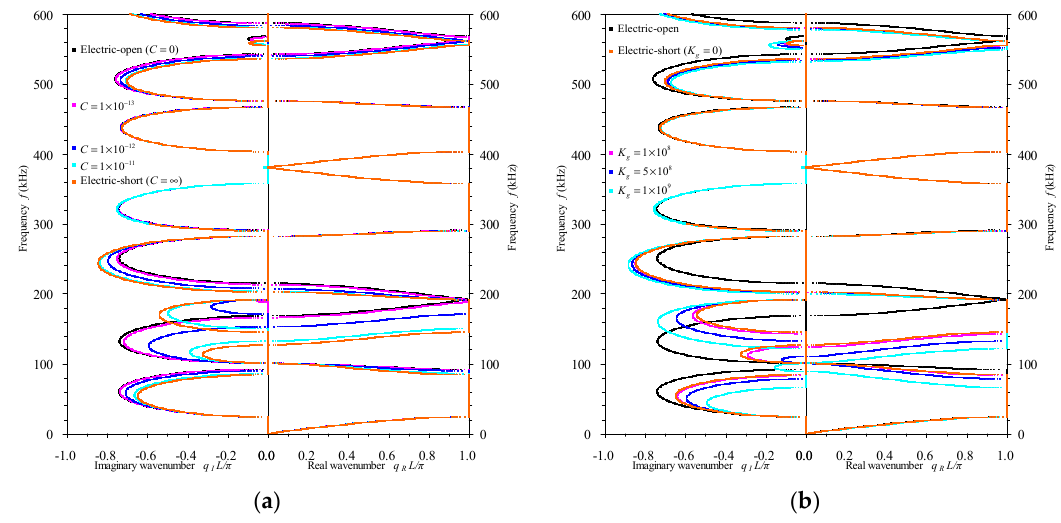
Figure 9. Influence of the electrical boundaries on the propagation constants spectra of the periodic Epoxy-Brass-PZT-5H-Brass composite rod: ( a ) applied electric capacity condition; and ( b ) applied feedback control condition.